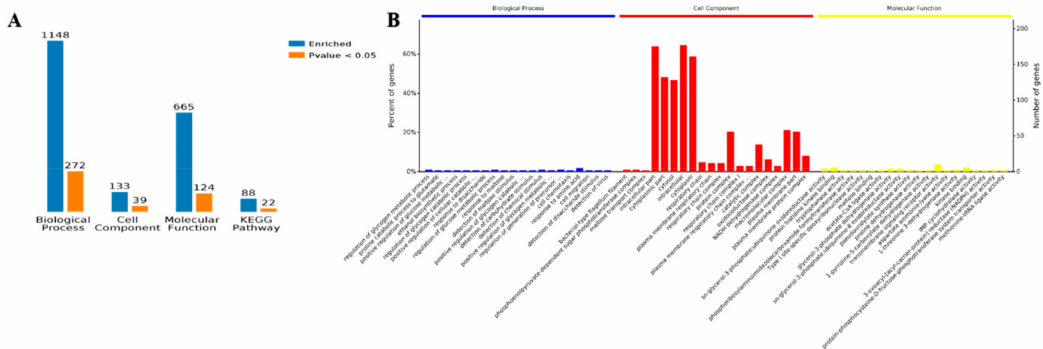
Figure 5. Gene Ontology (GO) annotation of the di ff erentially accumulated proteins of the planktonic and biofilm states. ( A ) The number of enrichment proteins with GO annotations and Kyoto Encyclopedia of Genes and Genomes (KEGG). ( B ) The percentage of proteins with GO